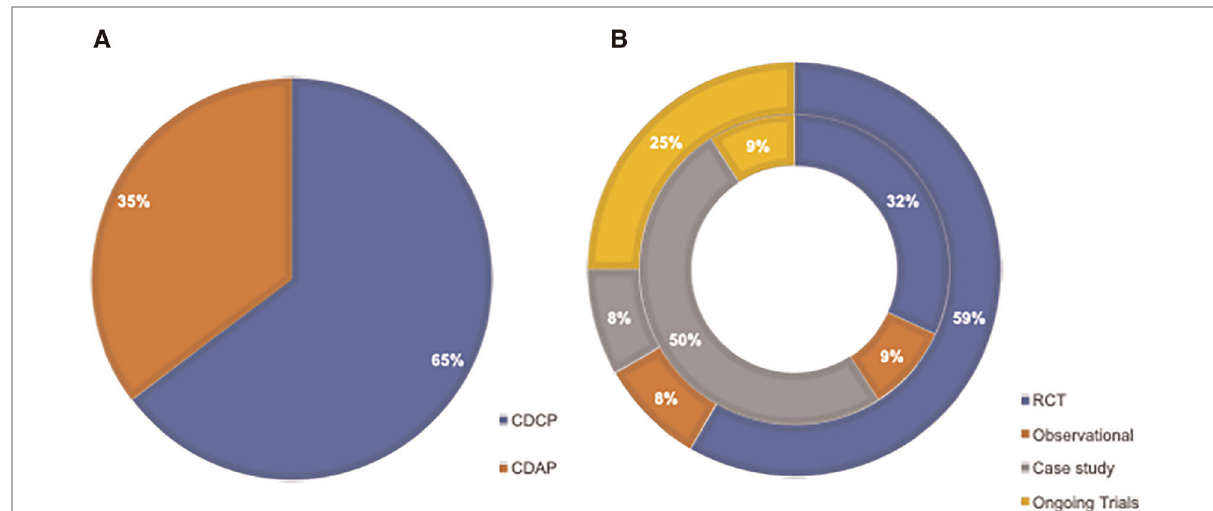
FIGURE 2 ( A ) Pie chart illustrating the breakdown of studies looking at CDCP vs. CDAP. ( B ) Sunburst chart illustrating the distribution of selected studies, including RCTs, observational, case studies, and registered (i.e., ongoing and planned) trials separated into those looking at CDAP (outer segment) and CDCP (inner segment). CDAP, comorbid depression and acute pain; CDCP, comorbid depression and chronic pain; RCT, randomized-controlled